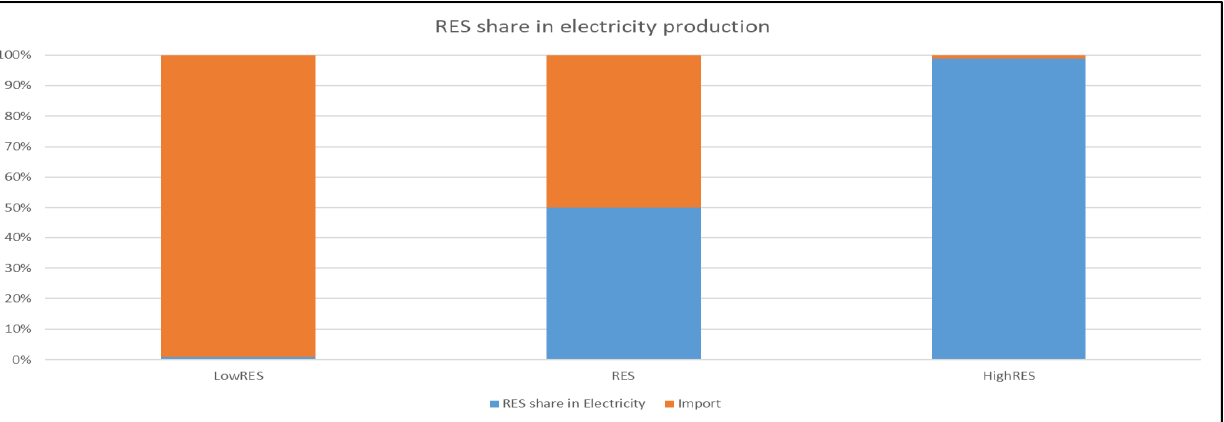
Figure 6. RES shares in the electricity supply.